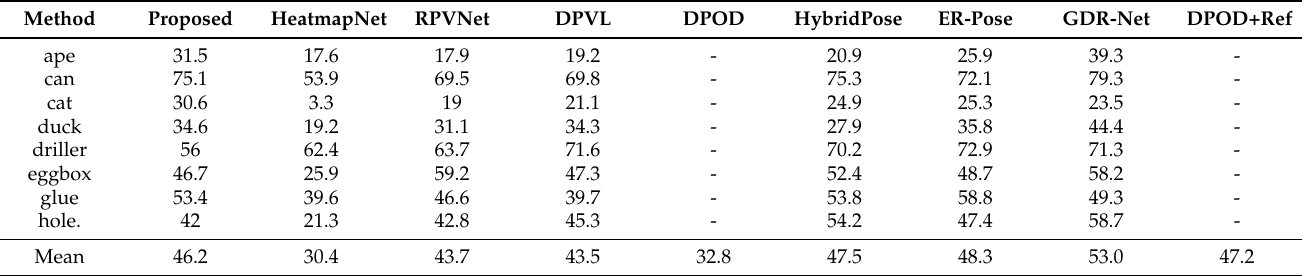
Figure 9. Visualizations of results on the Occlusion LINEMOD dataset. Table 4. Method accuracy comparison on the Occlusion LINEMOD dataset in terms of the ADD(-S)